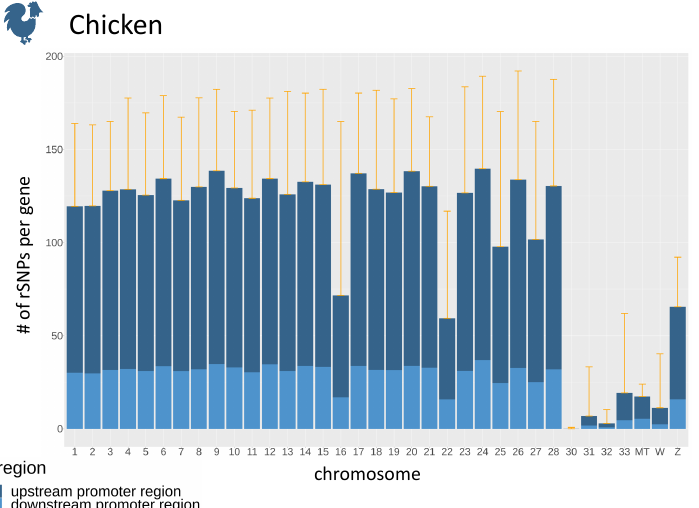
Figure 6. The average number of rSNPs in promoter regions per gene for each chromosome of chicken, divided into upstream and downstream promoters. The orange whiskers denote the mean plus one standard